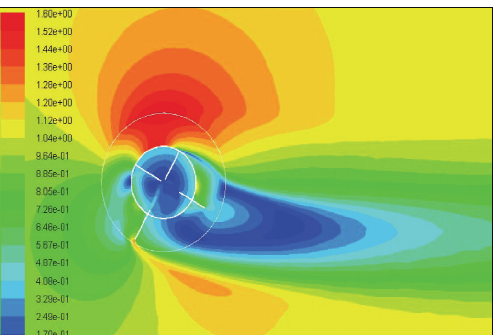
Figure 4: Velocity contours at a flow coefficient of 𝜆 = 0.4 and a rotational angle of 𝜃 = 60 ∘ .